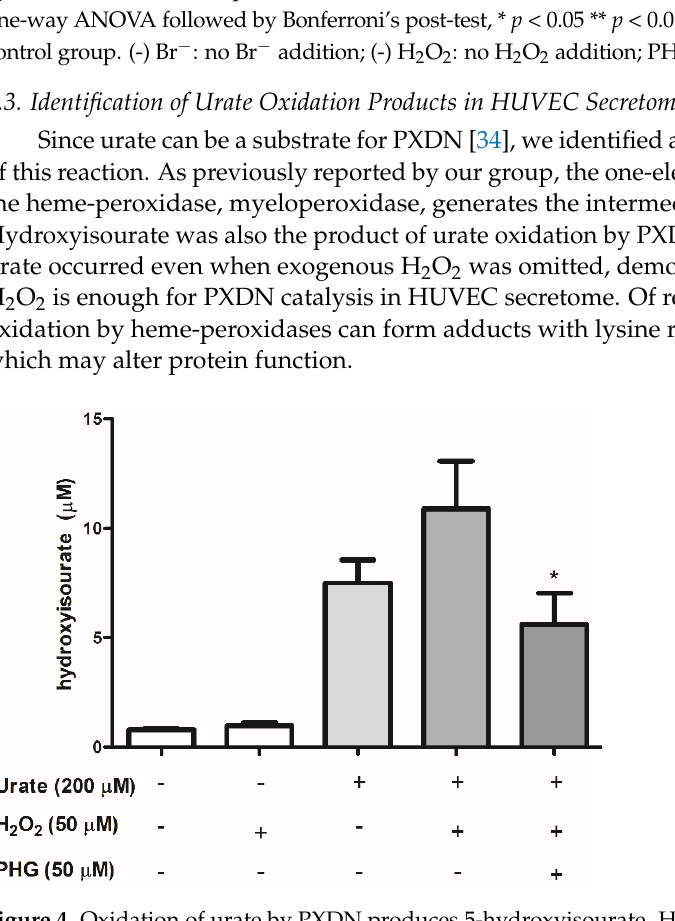
Figure 3. Urate decreases tyrosine bromination by PXDN. ( A ) Secretome from HUVEC and ( B ) extracellular matrix (ECM) from HEK293/PXDN overexpressing cells, which were incubated with tyrosine (1 mM), H 2 O 2 (100 µM) and NaBr (100 mM) (CTL group), urate (200 µM) or PHG (50 µM ) in 50 mM phosphate buffer (pH 7.4) for 4 h at 37 ºC before measurement of 3-bromotyrosine or 3,5-dibromotyrosine by HPLC. Each datum represents the mean ± S.E.M. (n = 3). Statistical analyses were performed by